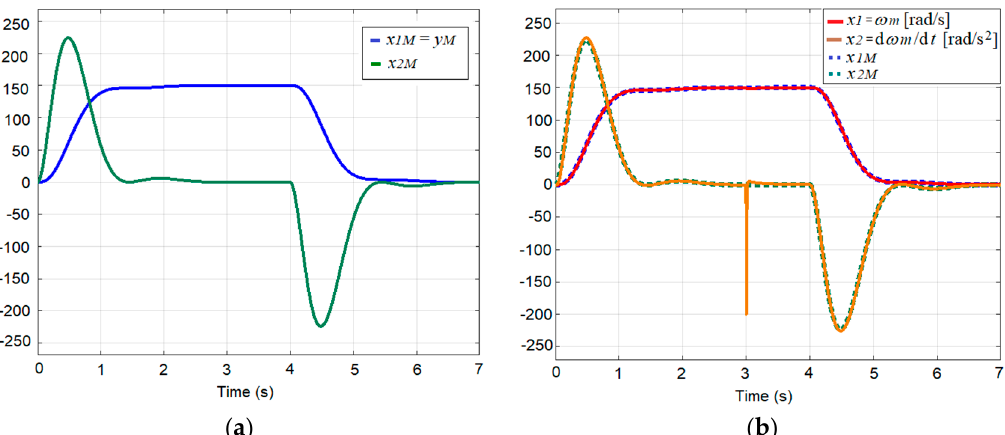
Figure 5. Time courses of the IM control during the operation cycle: ( a ) prescribed by the reference model, ( b ) achieved by the motor at its starting and loading.